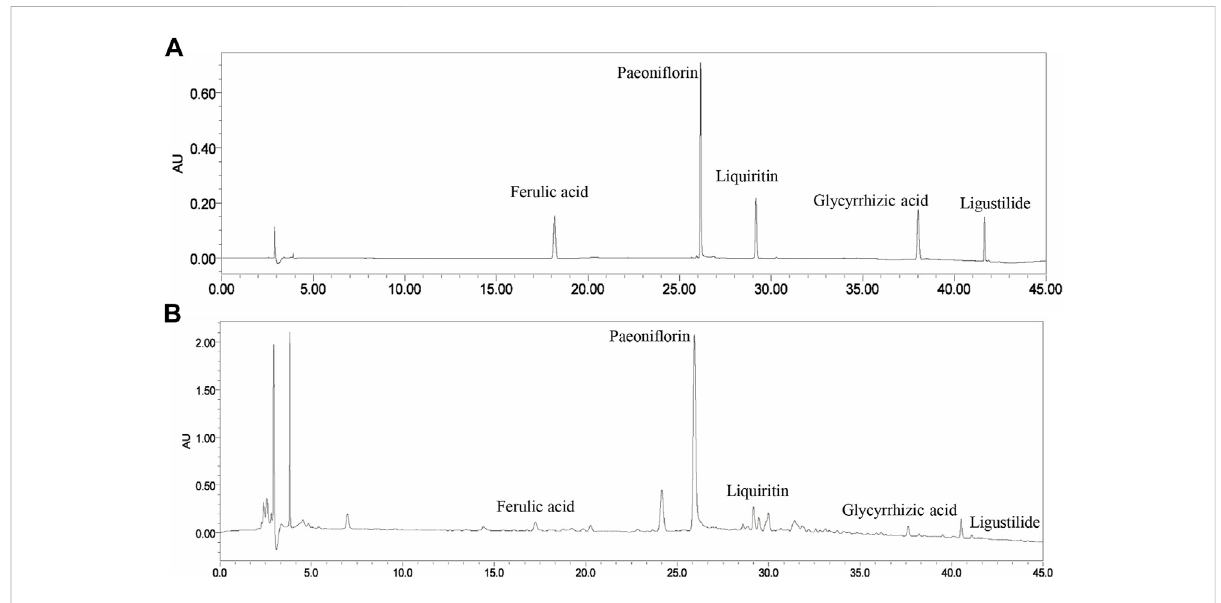
FIGURE 1 The HPLC fi ngerprints of XYS and its major components, including ferulic acid, paeoni fl orin, liquiritin, glycyrrhizic acid, and ligustilide. (A) Standards. (B)